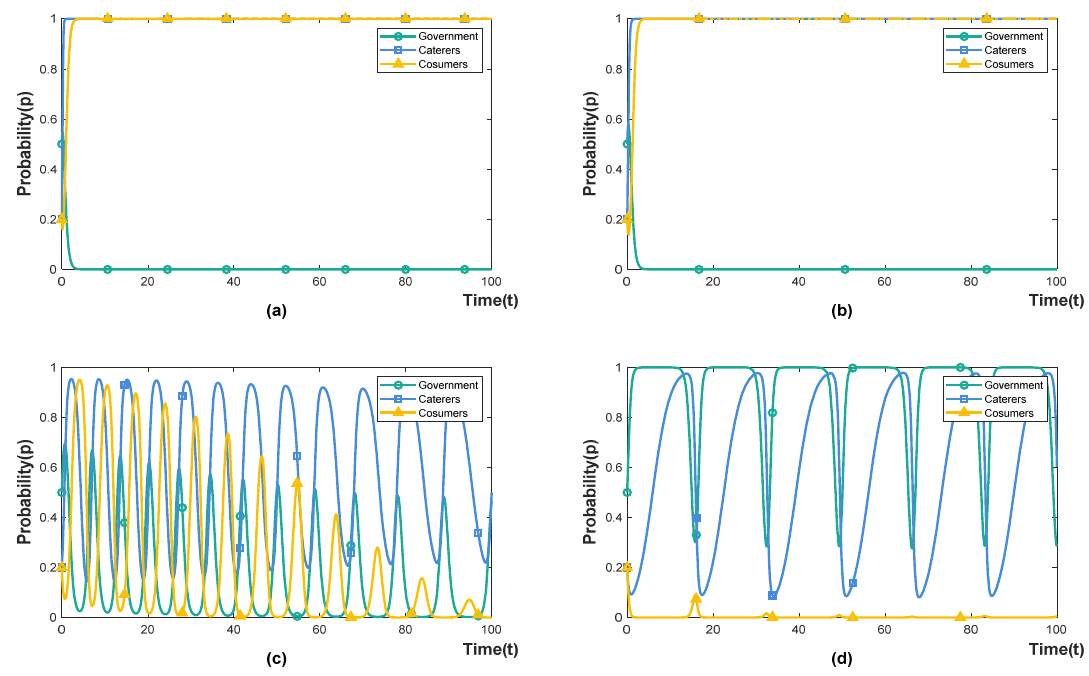
Figure 5. The effect of p on the evolution trajectory. ( a ) 𝑝 = 0.2 . ( b ) 𝑝 = 0.4 . ( c ) 𝑝 = 0.6 . ( d ) 𝑝 = 0.8 .